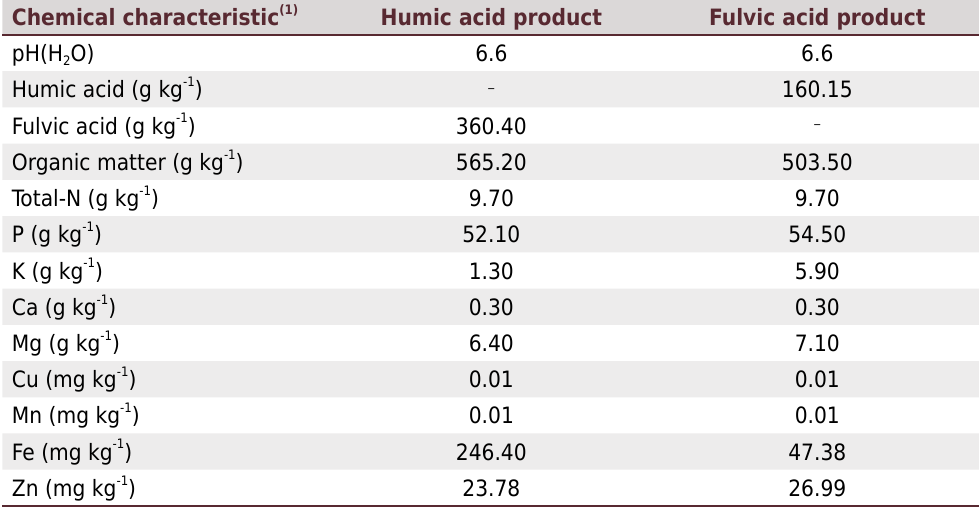
Table 2. Chemical characterization of the humic and fulvic acid products applied on soil samples from a multi-metal contaminated